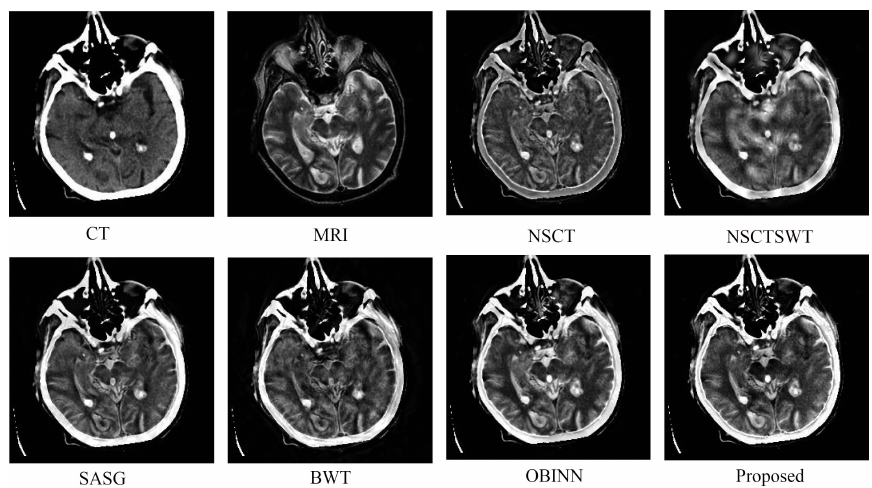
Fig. 5. CT and MRI images of the cerebral infarction and the fusion